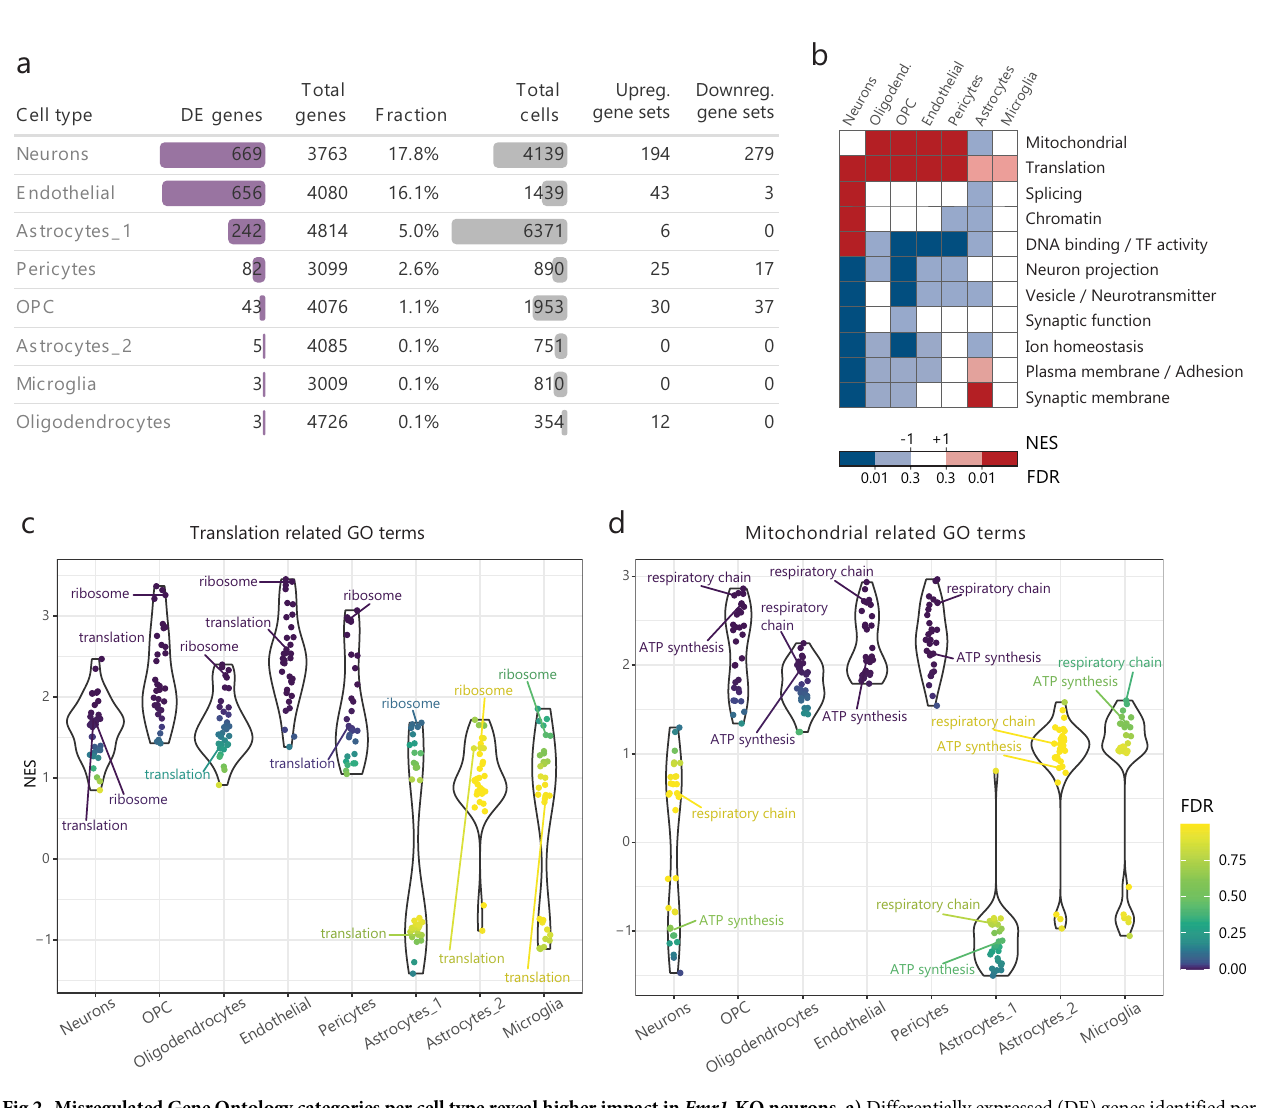
Fig 2. Misregulated Gene Ontology categories per cell type reveal higher impact in Fmr1 -KO neurons. a) Differentially expressed (DE) genes identified per cell type, all results refer to expression in Fmr1 -KO with respect to WT. Upregulated = Increased expression in Fmr1 -KO. Downregulated = Decreased expression in Fmr1 -KO. b) Summary diagram of enriched processes (dark red/blue; FDR < 0.01) and trends (light red = NES > 1, FDR < 0.3; light blue = NES < - 1, FDR < 0.3; NES = normalized enrichment scores) in other cell types. c-d) Comparison of normalized enrichment scores (NES) across cell types for GO terms involved in translational (d: e.g. Ribosome, GO:0005840; Translation, GO:0006412) or mitochondrial (e: e.g. Respiratory chain, GO:0070469; ATP synthesis = ATP synthesis coupled electron transport, GO:0042773) processes.